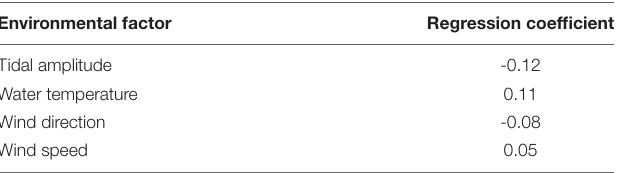
TABLE 3 | Contribution of environmental factors to beach wrack deposition evaluated by Partial least squares regression